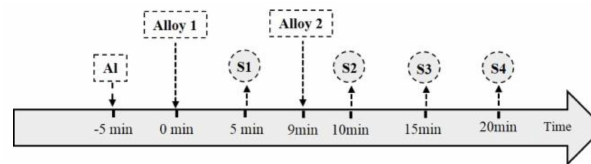
Figure 1. Schematic of tube furnace in the present experiments.